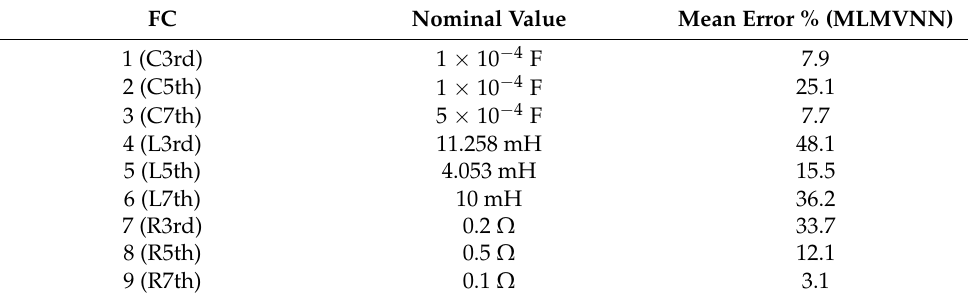
Table 7. Fault component identification